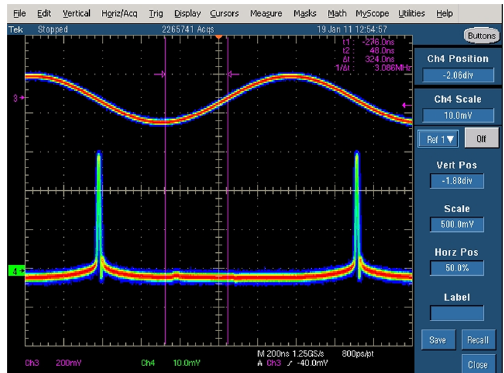
FIG. 7. Like Fig. 6 except for being a cooled beam. Most of the beam has been gathered into a narrow peak. Note the presence of a long residual uncooled tail on the